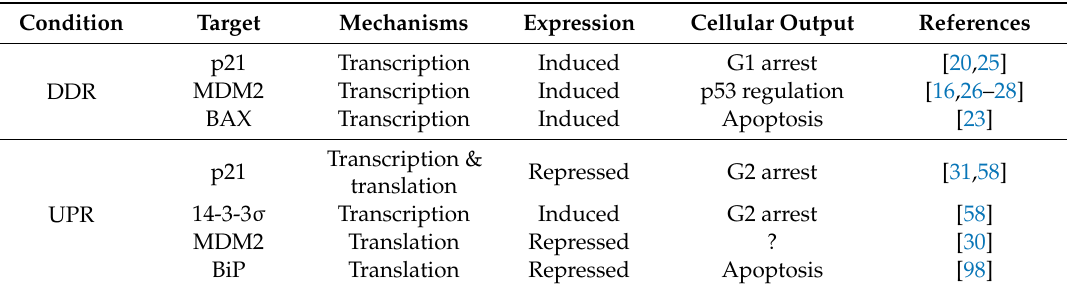
Table 1. Examples of the di ff erent regulatory outputs mediated by p53 isoforms during the DNA damage response (DDR) and